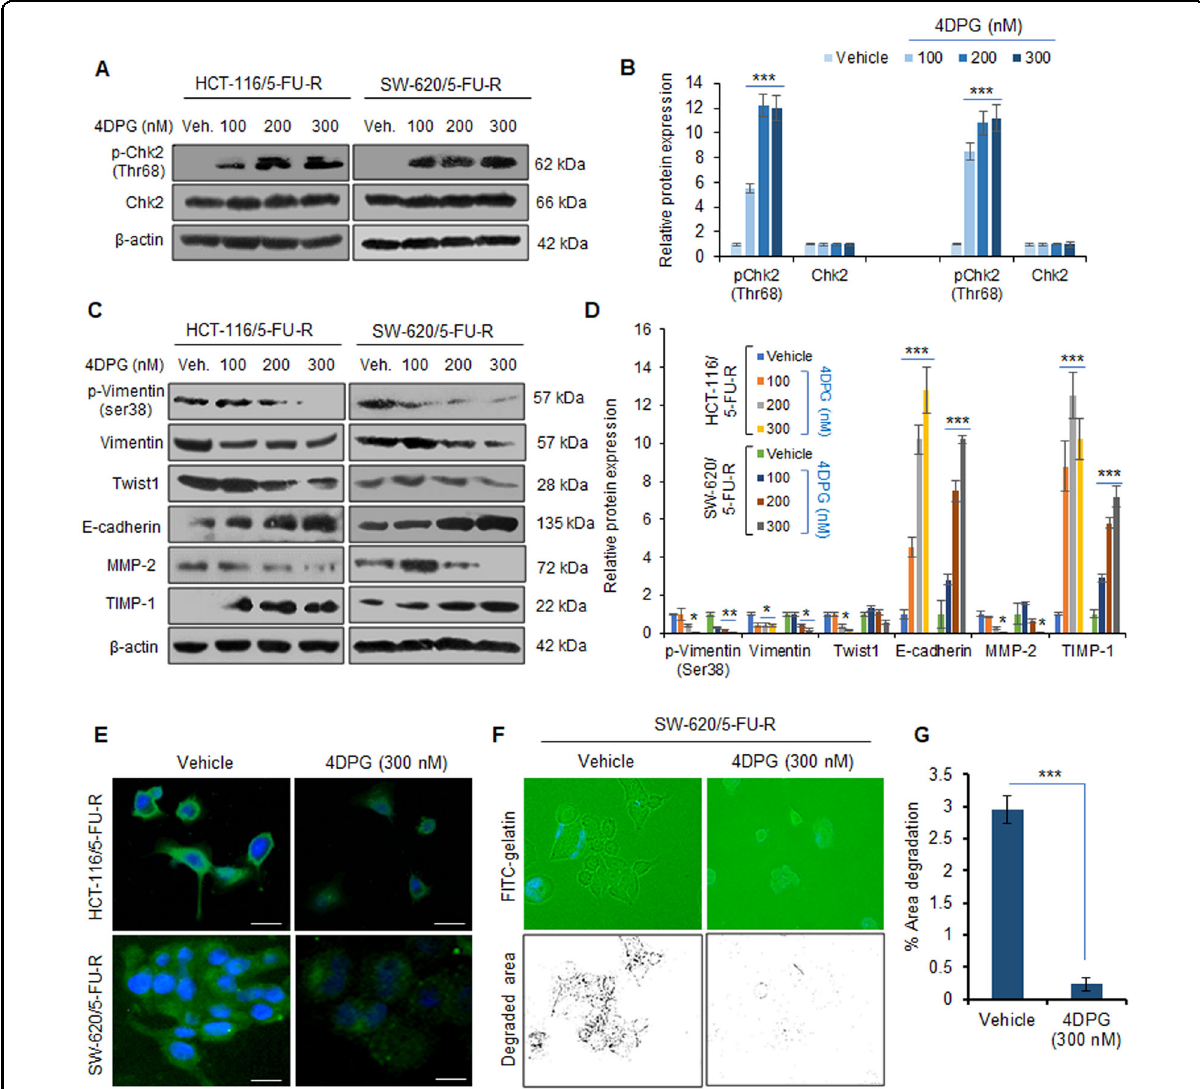
Fig. 2 4DPG activates Chk2 and attenuates EMT in 5-FU-R CRC cells. A Western blotting analysis results portraying protein expression of p-Chk2 (Thr68) and Chk2 in HCT-116/5-FU-R and SW-620/5-FU-R cells in response to increasing concentrations of 4DPG, treated for 48 h. β -Actin expression was considered as endogenous loading control. B Densitometry analysis showing relative protein expression of western blot bands presented above. n = 3, error bars: mean ± SD; *** P < 0.001. C Western blots depicting protein expression of EMT markers in HCT-116/5-FU-R and SW-620/5-FU-R cells in response to increasing concentrations of 4DPG, treated for 48 h. β -Actin expression was considered as endogenous loading control. D Densitometry analysis of western blots presented in ( C ) showing quanti fi cation of protein expression. n = 2, error bars: mean ± SD; * P < 0.05, ** P < 0.01, *** P < 0.001. E Immunocytochemistry results displaying the protein expression levels of Vimentin in HCT-116/5-FU-R and SW-620/5-FU-R cells, treated with vehicle and/or 4DPG (300 nM) for 48 h. Scale bars: 50 µm. F In situ fl uorescent gelatin degradation assay results showing the invadopodia/footprints of invaded SW-620/5-FU-R cells treated with vehicle and/or 4DPG at the indicated concentration for 48 h. Blue stains over the green background display DAPI staining of nuclei of cells. G Quanti fi cation of the area of degradation through Image J software. n = 3, error bars, mean ± SD; *** P <